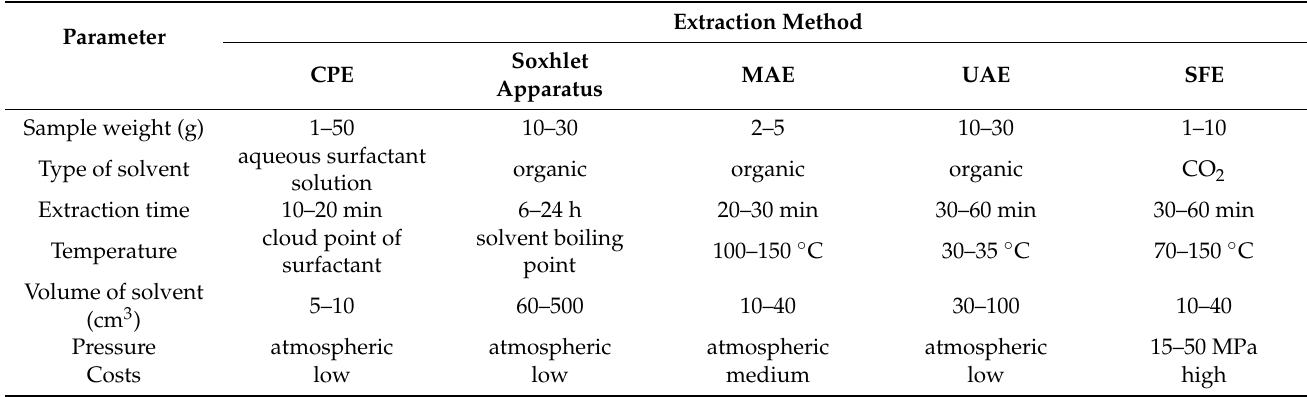
Table 1. Comparison of CPE and other extraction methods (MAE—microwave-assisted extraction, UAE—ultrasound- assisted extraction, SFE—supercritical fluid extraction)